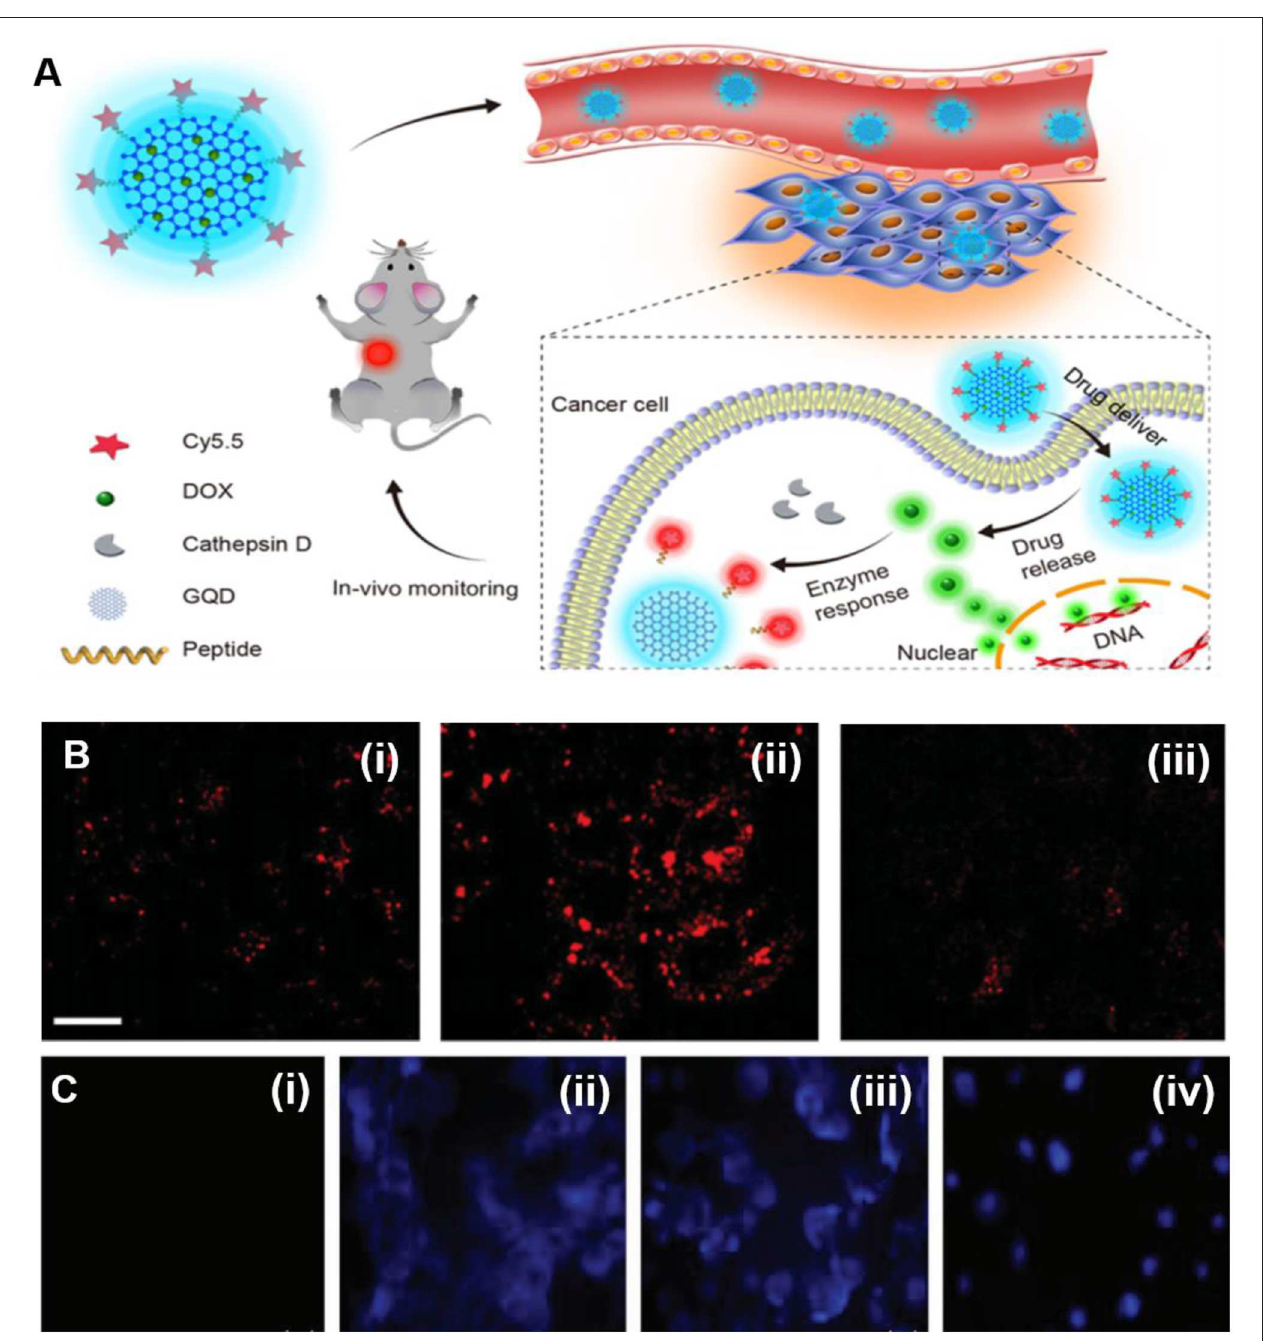
FIGURE 9 | (A) Strategy of in vivo monitoring of drug and tumor therapy by GQD-based theranostic agent; reproduced from Ding et al. (2017) with permission from the American Chemical Society. (B) Confocal fluorescence (FL) images of HeLa cells incubated with GQDs (i), PNF-GQDs (ii), and CO-7 cells incubated with protein nanofiber-conjugated GQDs (PNF-GQDs) (PNF-GQDs) (iii); reproduced from Su et al. (2015) with permission from Wiley. (C) Confocal FL images of BMSC (i), MCF7 (ii), MDA-MB-231 (iii), and SKOV3 (iv) under ultraviolet (UV) light irradiation, reproduced from Zhang et al. (2019a) with permission from Wiley.